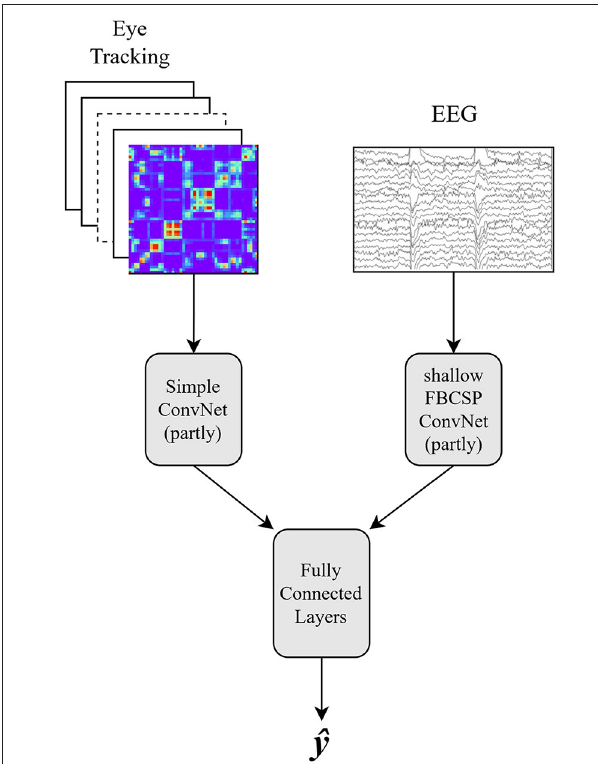
FIGURE 4 | Late fusion approach using image features for eye tracking data in combination with a Simple Convolutional Neural Network and the time series of EEG data with the shallow FBCSP Convolutional Neural Network. The probabilities of the predictions P ( ˆ y ) are used for the final prediction ˆ y